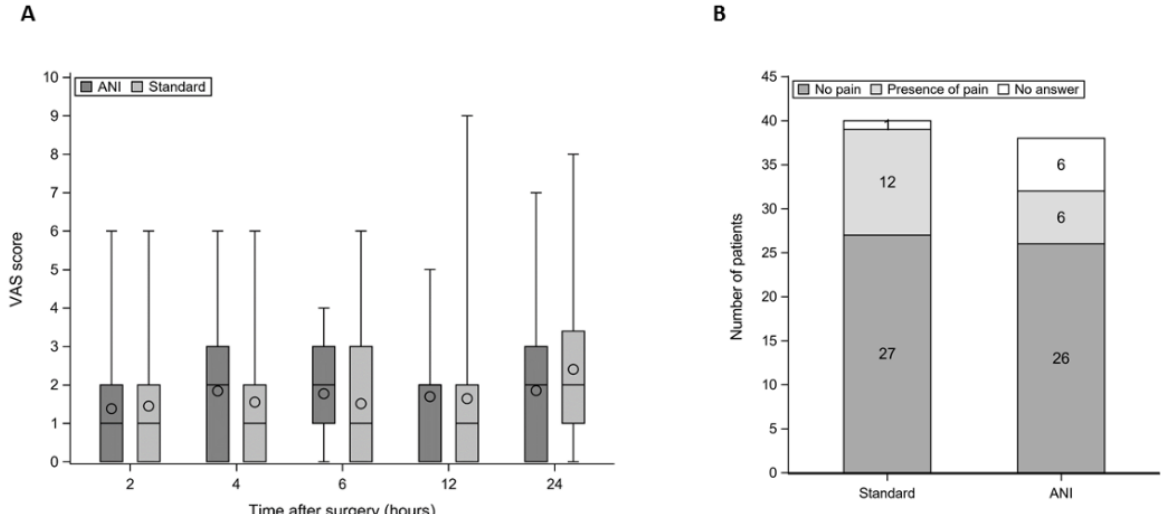
Figure 4. Postoperative pain with ( A ) acute pain during the first 24 h, by visual analog scale (VAS) in the ANI and Standard groups. Mean is represented by circle and median by the horizontal line inside the box; and ( B ) chronic pain at the surgical site 3 months after the procedure (phone survey). Light gray indicates number of patients who reported persistent pain; dark gray indicates number of patients who reported no persistent pain; white indicates number of patients who did not answer our phone calls.